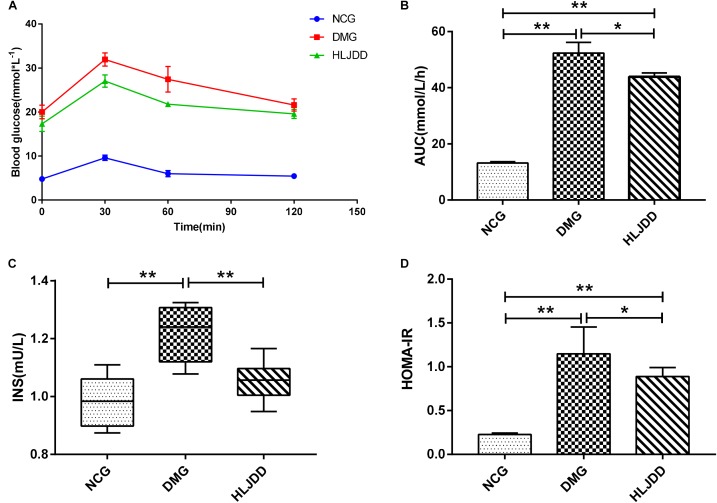
Intervention of HLJDD improves oral glucose tolerance and decreases serum insulin levels. (A) Oral glucose tolerance test; (B) AUC calculating from the glucose concentrations after glucose load; (C) serum insulin levels determined after treatment for 4 weeks; and (D) HOMA-IR index calculating from the following formula: HOMA-IR = FINS × FBG/22.5. Values are expressed as means ± SD. Differences were assessed by ANOVA and denoted as follows: ∗∗p < 0.01, ∗p < 0.05 vs. DMG (n = 8).